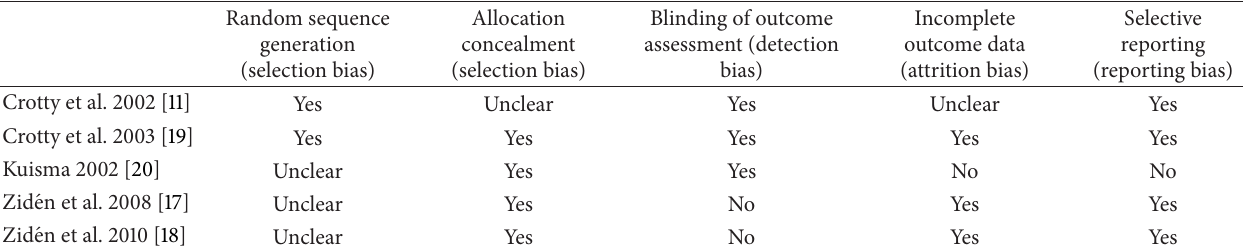
Table 2: Risk of bias assessment of included studies (Yes—No risk of bias, No—clear risk of bias, Unclear—indicates that risk of bias is